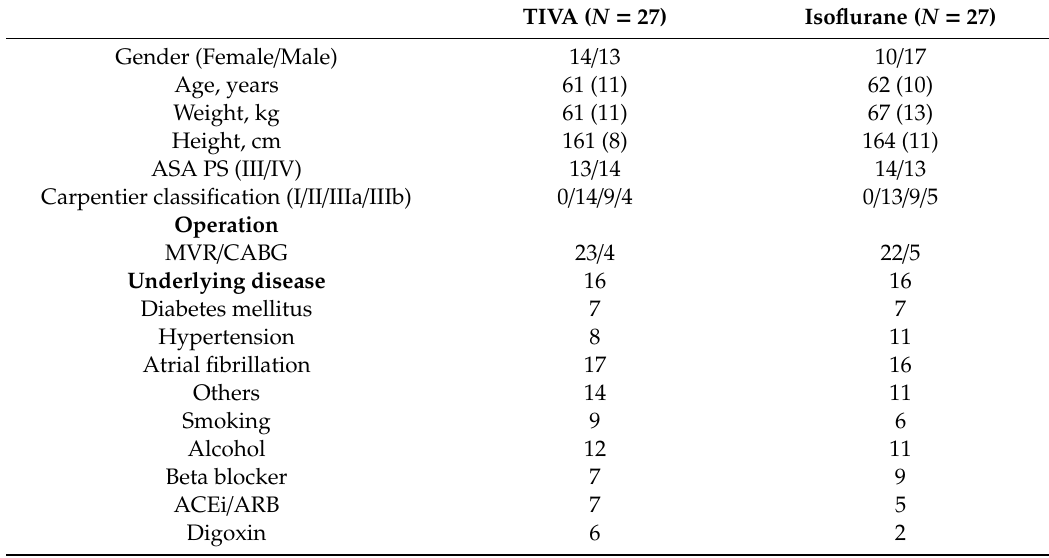
Table 1. Demographic data.